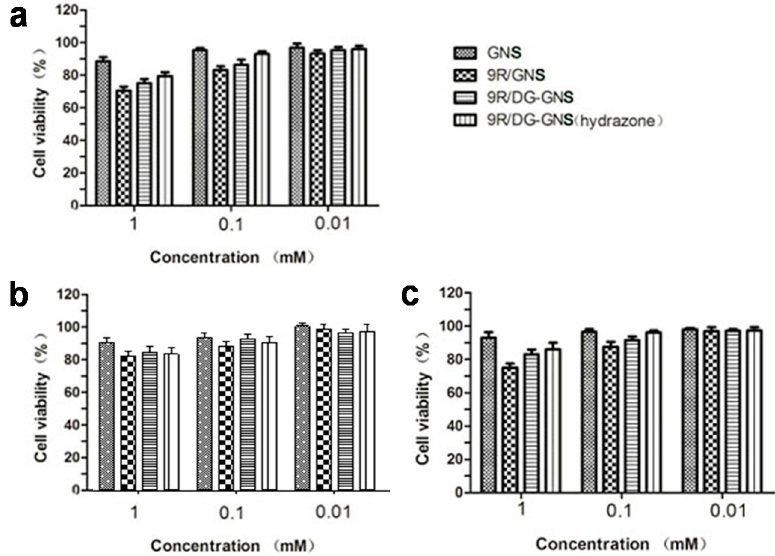
Figure 4. Cytotoxicity of GNS, 9R-GNS, 9R/DG-GNS, and 9R/DG-GNS (hydrazone) in HepG2 ( a ), SGC7901 ( b ), and HUVEC ( c ) cells. Data are represented as mean ± SD ( n = 3).